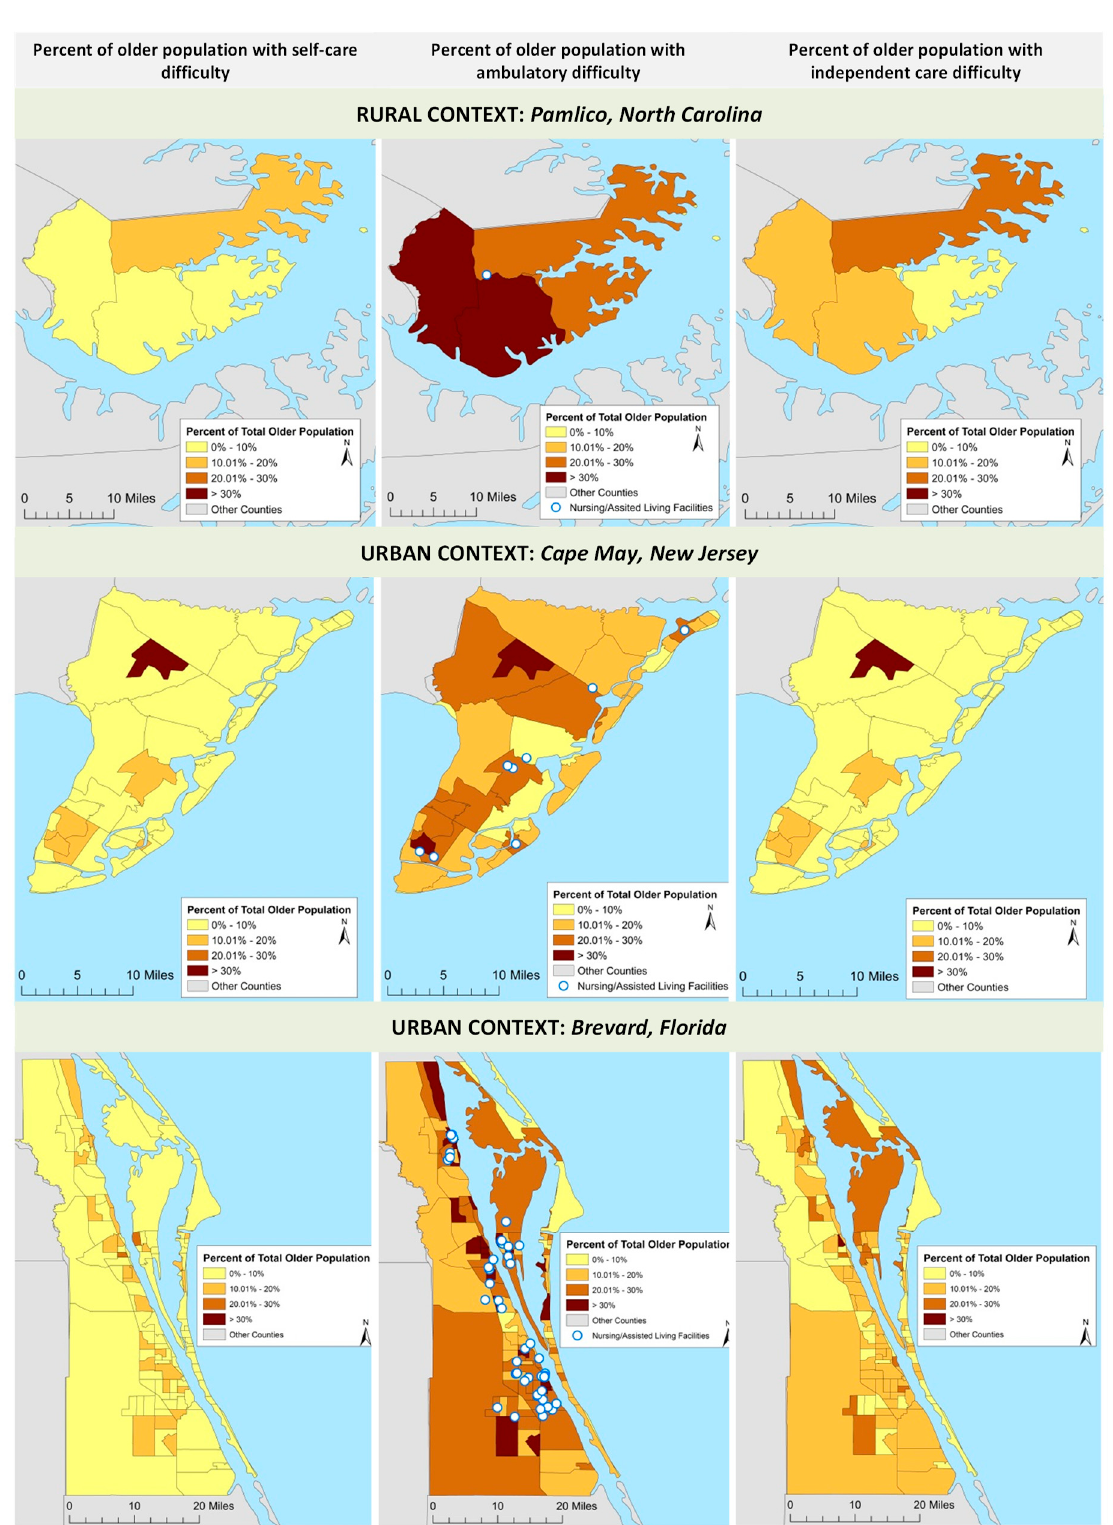
Figure 2. Tract level distribution of self-care, ambulatory, and independent living disabilities in three case study locations.